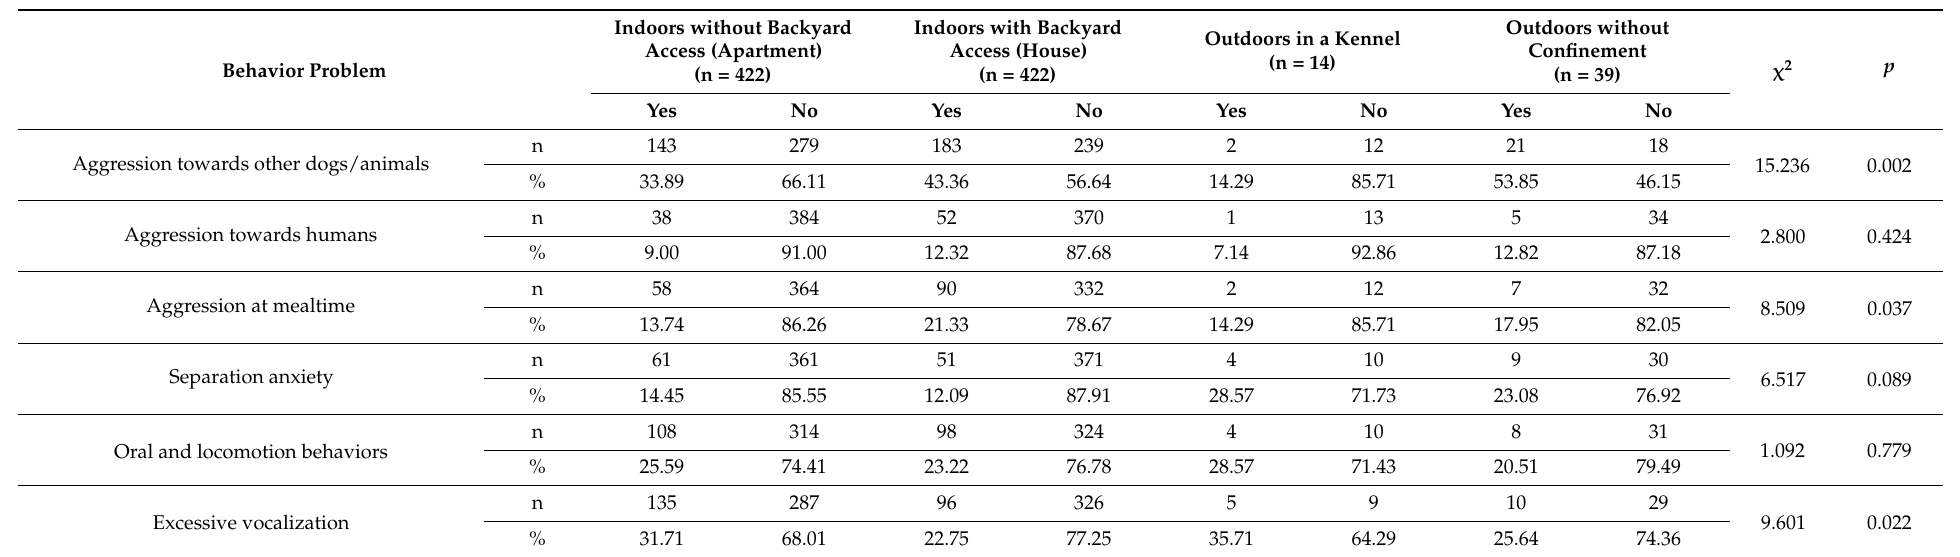
Table 6. The influence of present housing conditions on the incidence of undesirable behaviors in ancient dog